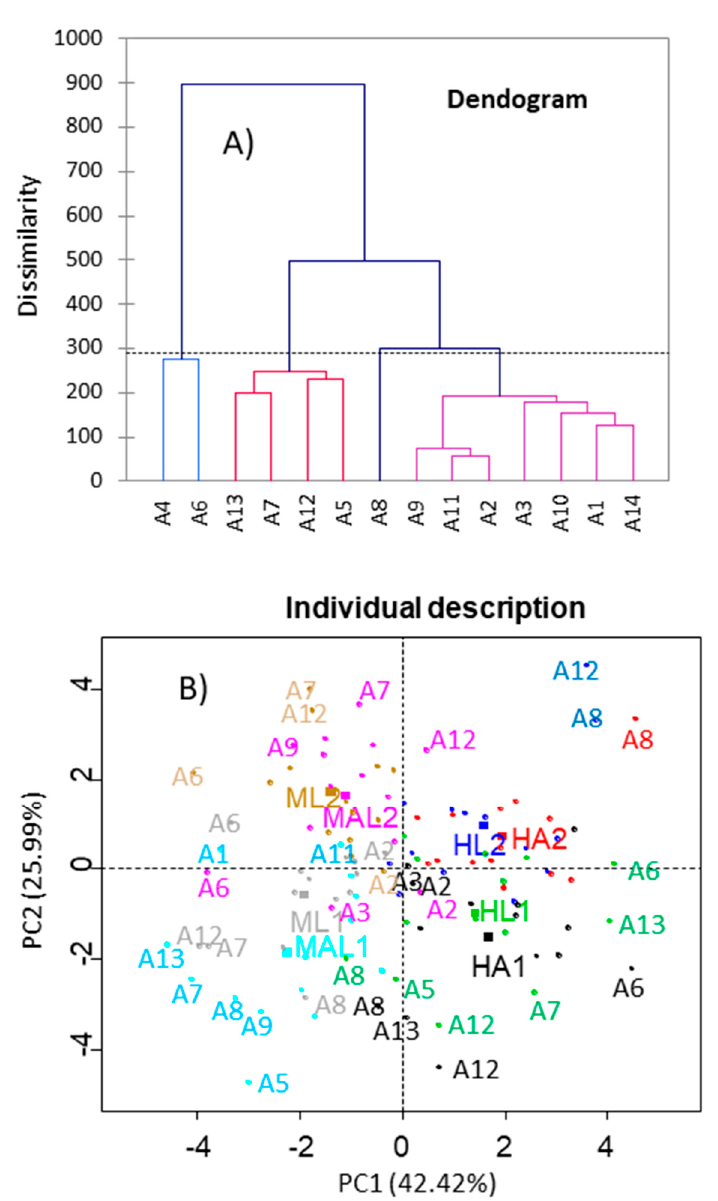
Figure 7. Panelist performance as assessed by multivariate analysis. ( A ) Clustering of panelists according to their performance. ( B ) Projection of panelists’ loads (individual description) and samples’ scores onto the first two Principal Components.